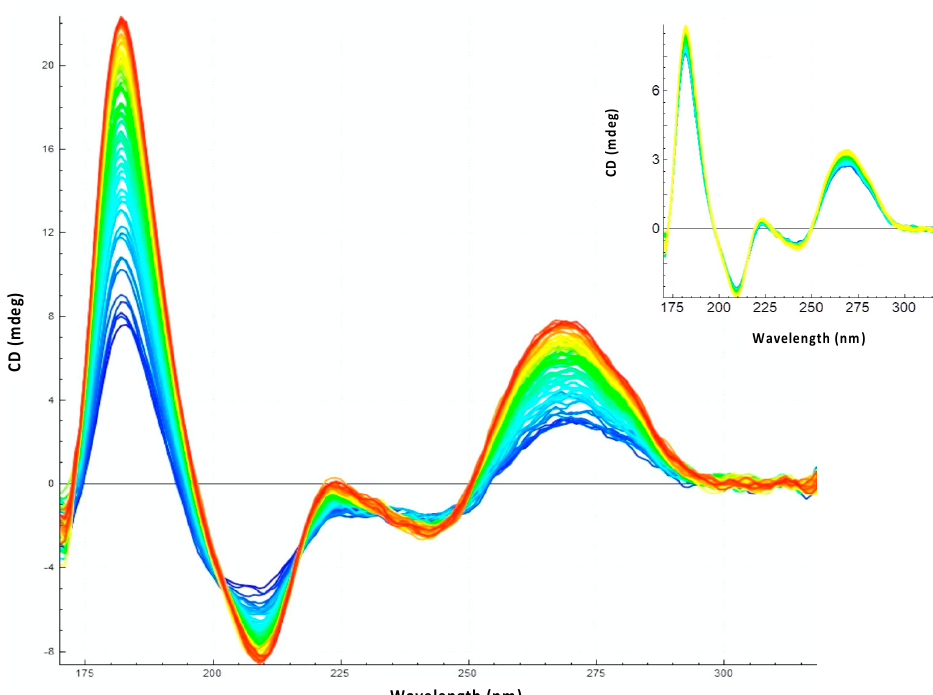
Figure 2. Observation of DsrA core and rpoS reg annealing by Hfq-CTR using SRCD (from blue t = 0 min to red t = 300 min). Inset: control without the protein; no significant RNA annealing occurs without the protein.